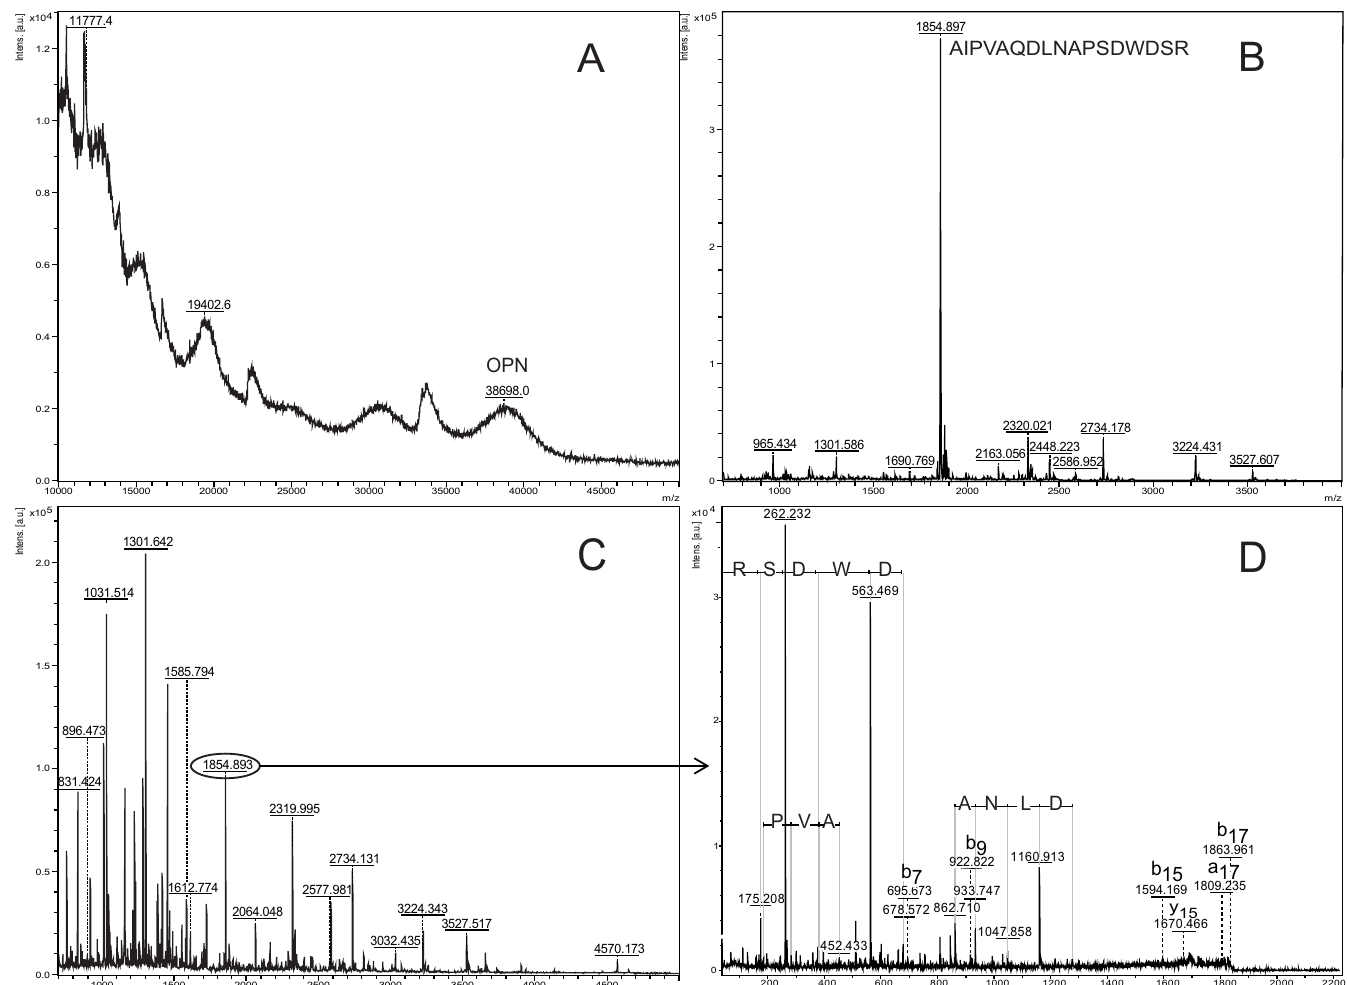
Fig 5. MALDI-MS and MS/MS of Elution fraction 3, from human plasma samples. (A) Spiked with 1 mg/mL rhOPN, intact protein. (B) Spiked with 1 mg/mL rhOPN, trypsin digest. (C) Spiked with 100 μ g/mL rhOPN, trypsin digest. (D) Spiked with 100 μ g/mL rhOPN, MS/MS on m/z 1854.898 from trypsin digest.